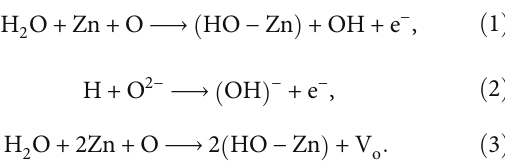
gas concentration at 2